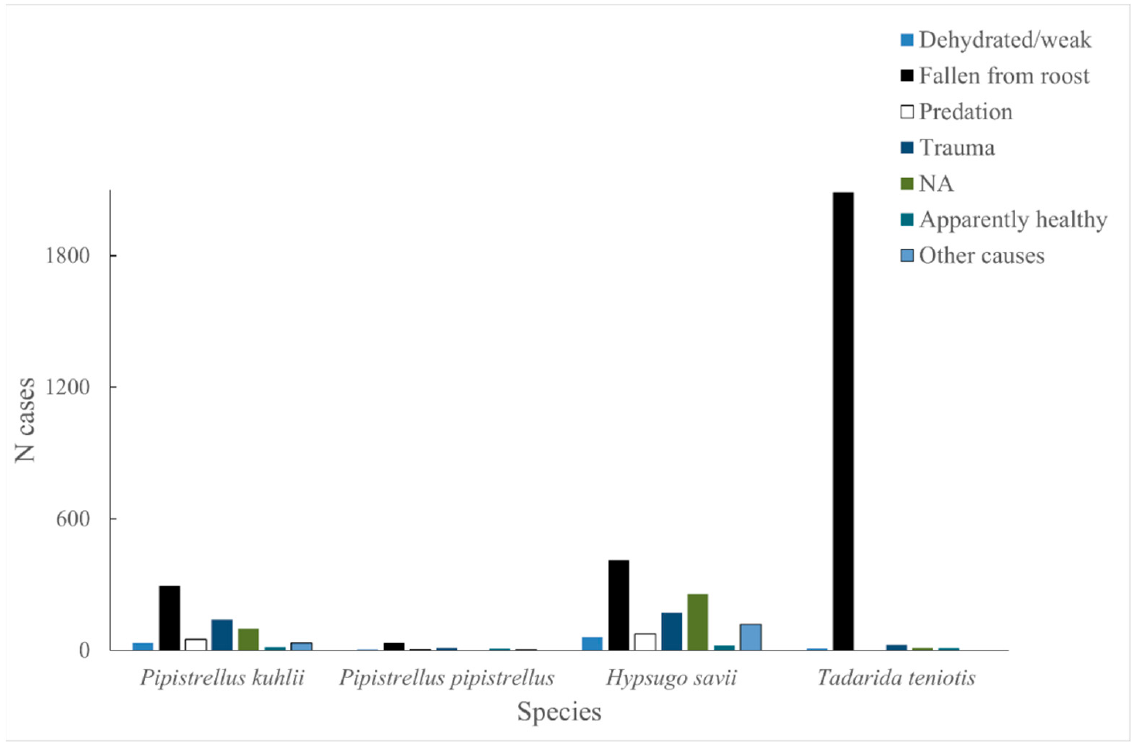
Figure 2. Causes of bat admittance to four Italian wildlife rehabilitation centres. In the legend, NA refers to individual bats for which no information was available.